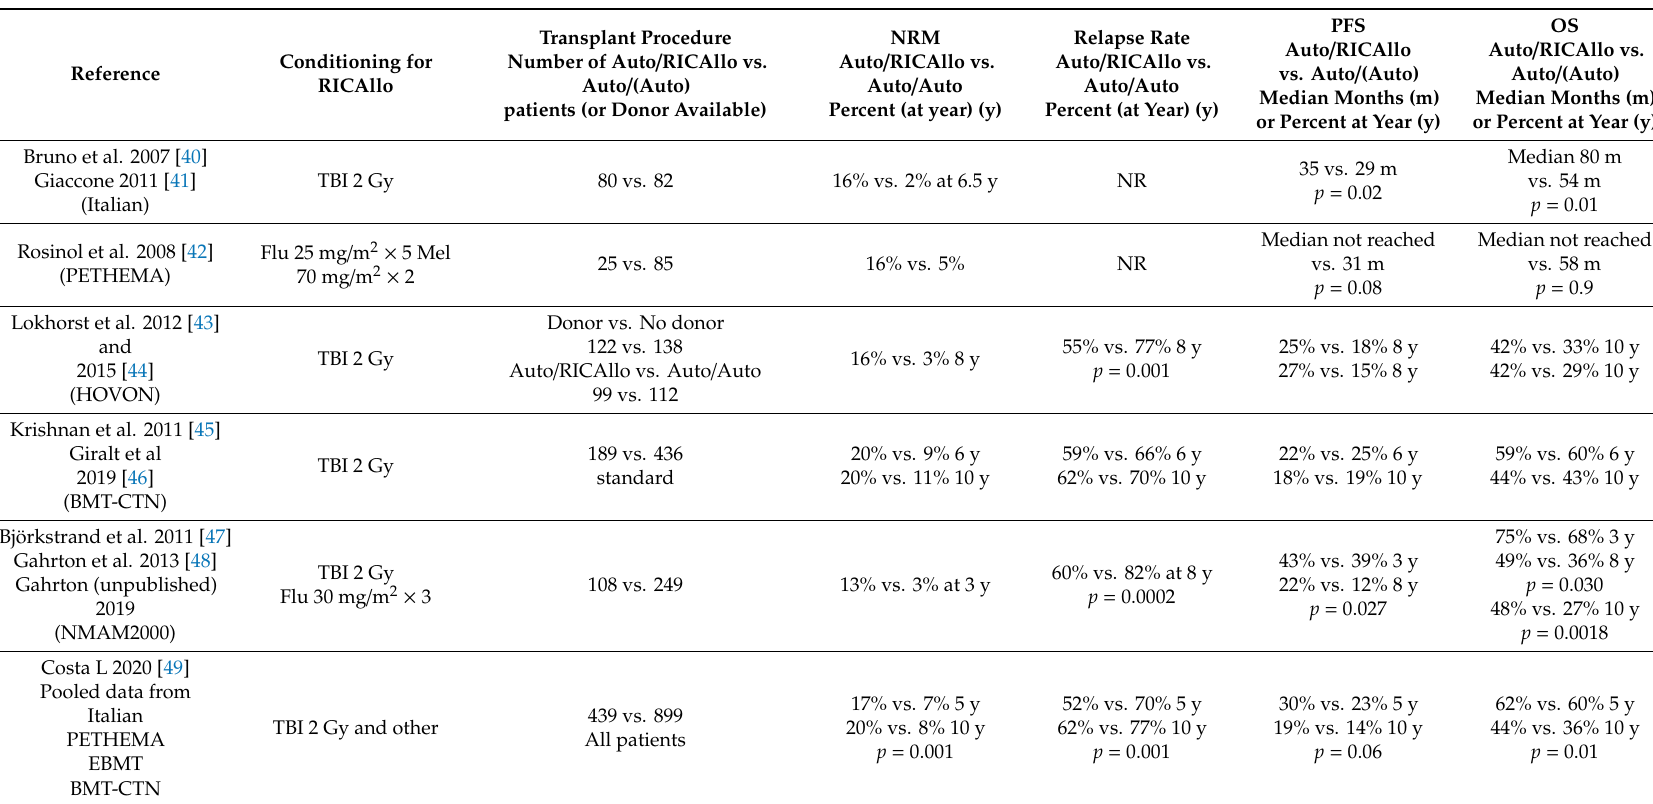
Table 1. Prospective studies comparing autologous (Auto) combined with reduced-intensity conditioning (RIC) allogeneic transplantation (Auto / RICAllo) to single Auto or tandem Auto (Auto / Auto) in upfront-treated standard or mixed risk multiple myeloma (MM)